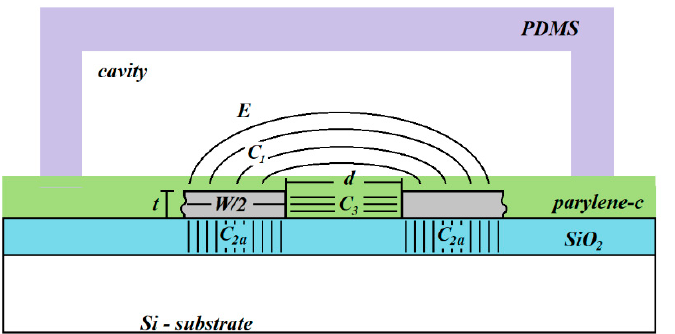
Figure 2. Coplanar capacitive sensor cross section and the main capacitive components. Additionally, the geometrical parameters are shown: W is the metal width, d is the spacing between the metal lines, and t is the metal thickness.